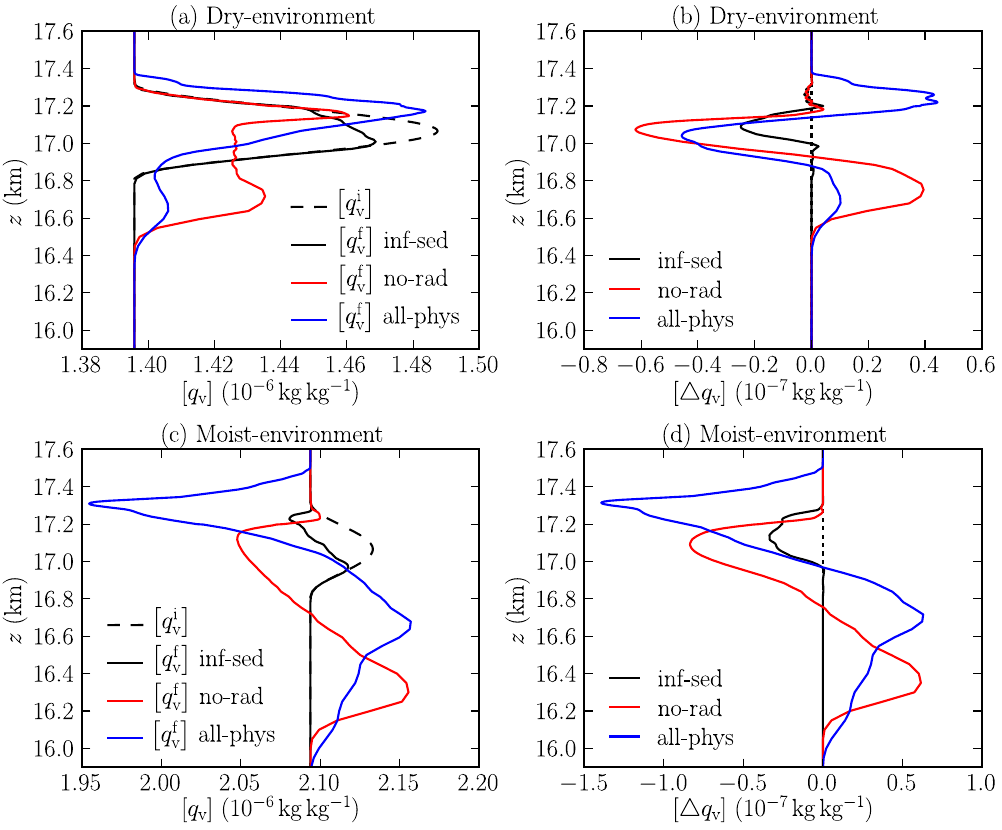
Figure 4. The horizontal-domain average of the initial and final water vapour mixing ratio q v (left column), and changes in q v (right column) in the dry (top row) and moist (bottom row)